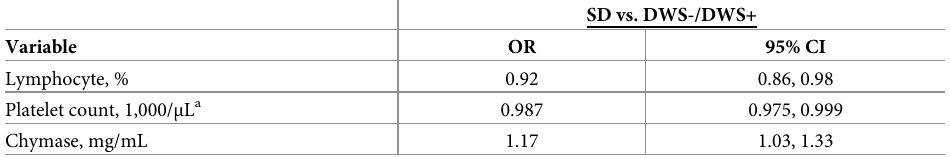
Abbreviations: CI, confidence interval; OR, odds ratio a Three decimal places shown for